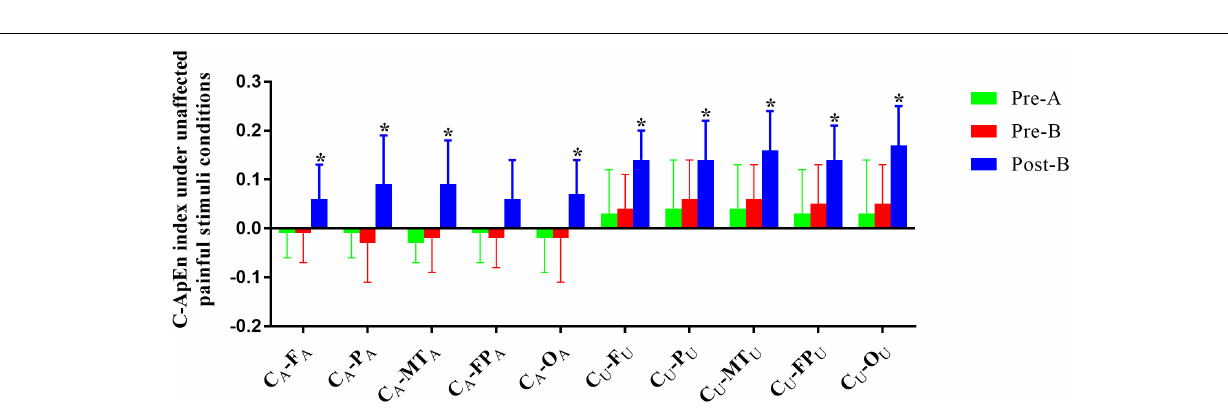
FIGURE 6 | C-ApEn index under the unaffected painful-stimuli condition. * p < 0.05 was considered statistically significant.